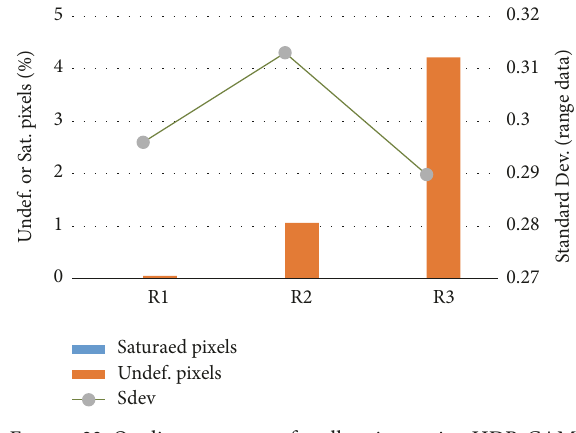
Figure 23: Quality parameters for all regions using HDR-CAM.